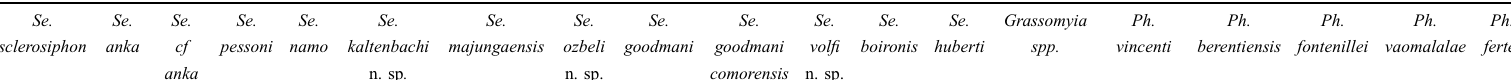
Table 3. Genetic distances between taxa based on cyt B mtDNA sequences. In bold, the intraspeci fi c distances.